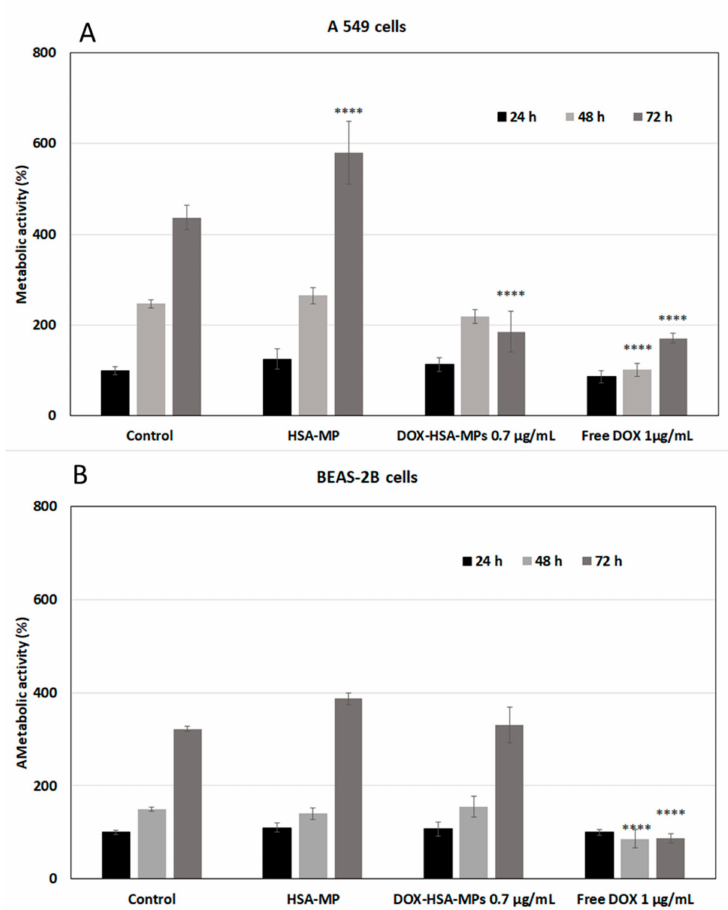
Figure 5. Metabolic activity of A549 lung tumor cells ( A ) and BEAS-2B bronchial epithelial cells ( B ) treated with HSA-MPs, DOX-HSA-MPs (10,000 particles per cell, corresponding to 0.725 µ g / mL DOX) and free DOX (1 µ g / mL) for 24, 48 and 72 h compared to untreated cells (control) using the Cell Counting Kit-8 (CCK-8) assay. The data are represented as two way ANOVA, Tukey’s multiple comparisons. The error bar represents mean ± SD; **** p < 0.001. The metabolic activity of the control after 24 h was taken as